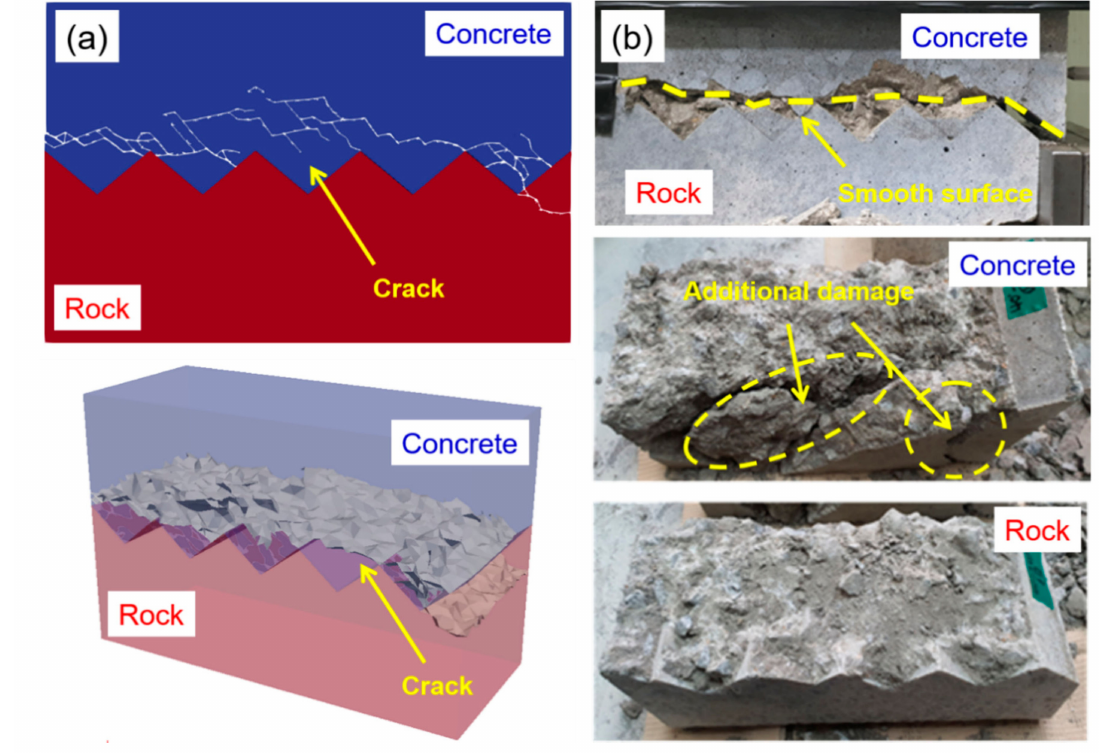
Figure 12. A comparison of the resultant fracture pattern in the shear test with the rough concrete–rock joint in the case of an asperity angle of α = 40 degrees: ( a ) numerical simulation and ( b ) experiment